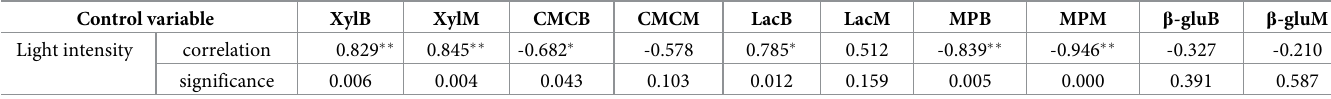
Table 4. The result on correlation analysis of light intensity and five